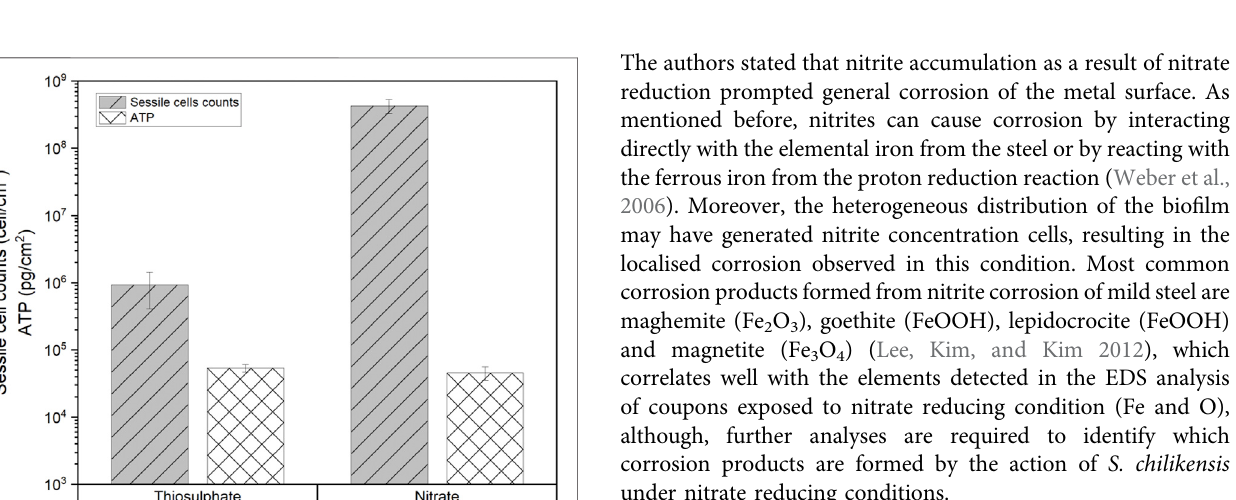
FIGURE 9 | CLSM images of bio fi lms formed by S. chilikensis after 16-days exposure to thiosulphate (A) and nitrate (B) reducing conditions.